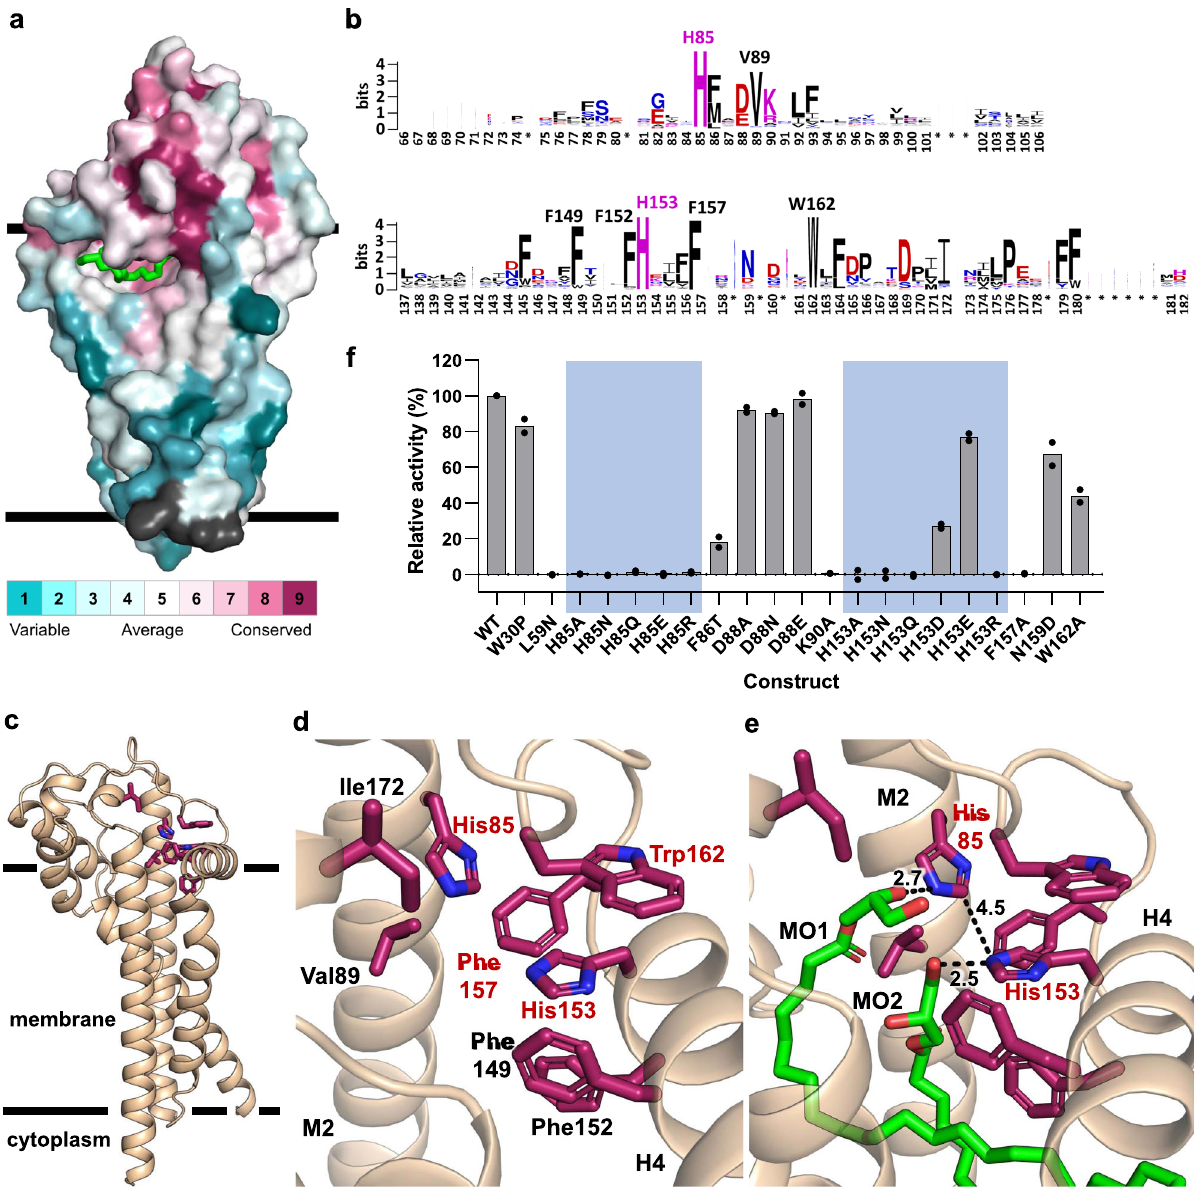
Fig. 3 Location and mutational analysis of conserved residues demark putative active and substrate binding sites in Lit. a Structure of Lit with conserved residues colour coded from blue to purple corresponding to low and high % conservation, respectively. b Sequence logo 74 representation of a Clustal Omega 71 sequence alignment of 788 Lit orthologs from the UniProt Reference Proteomes database 68 . c View from the membrane at the eight conserved residues (purple carbons) in Lit that are assumed to de fi ne the substrate-binding pocket. The pocket resides at and above the surface of the membrane (black bars). Conserved residues are at ≥ 90% conservation. d A zoomed in view of the conserved residues in Lit from which internal lipids have been removed. Red lettering denotes highly conserved residues ( ≥ 98% conservation). e A zoomed in view of the conserved residues in Lit along with the structured monoolein molecules that co-crystallise with the enzyme. Electron densities that de fi ne the lipid molecules are shown in Supplementary Fig. 6. The lipids are considered surrogates for the diacylglyceryl chains in the lipoprotein substrate. Distances shown as dashed lines are in ångströms. f Transferase activity of Lit mutants. Values are expressed as a percentage of wild-type (WT). A TLC assay was used to quantify Lit activity with FP2 as substrate on the basis of a 30 min incubation at 37 °C. The standard deviation is calculated on the basis of duplicate measurements. Mutants of the putative catalytic residues H85 and H153 are highlighted for